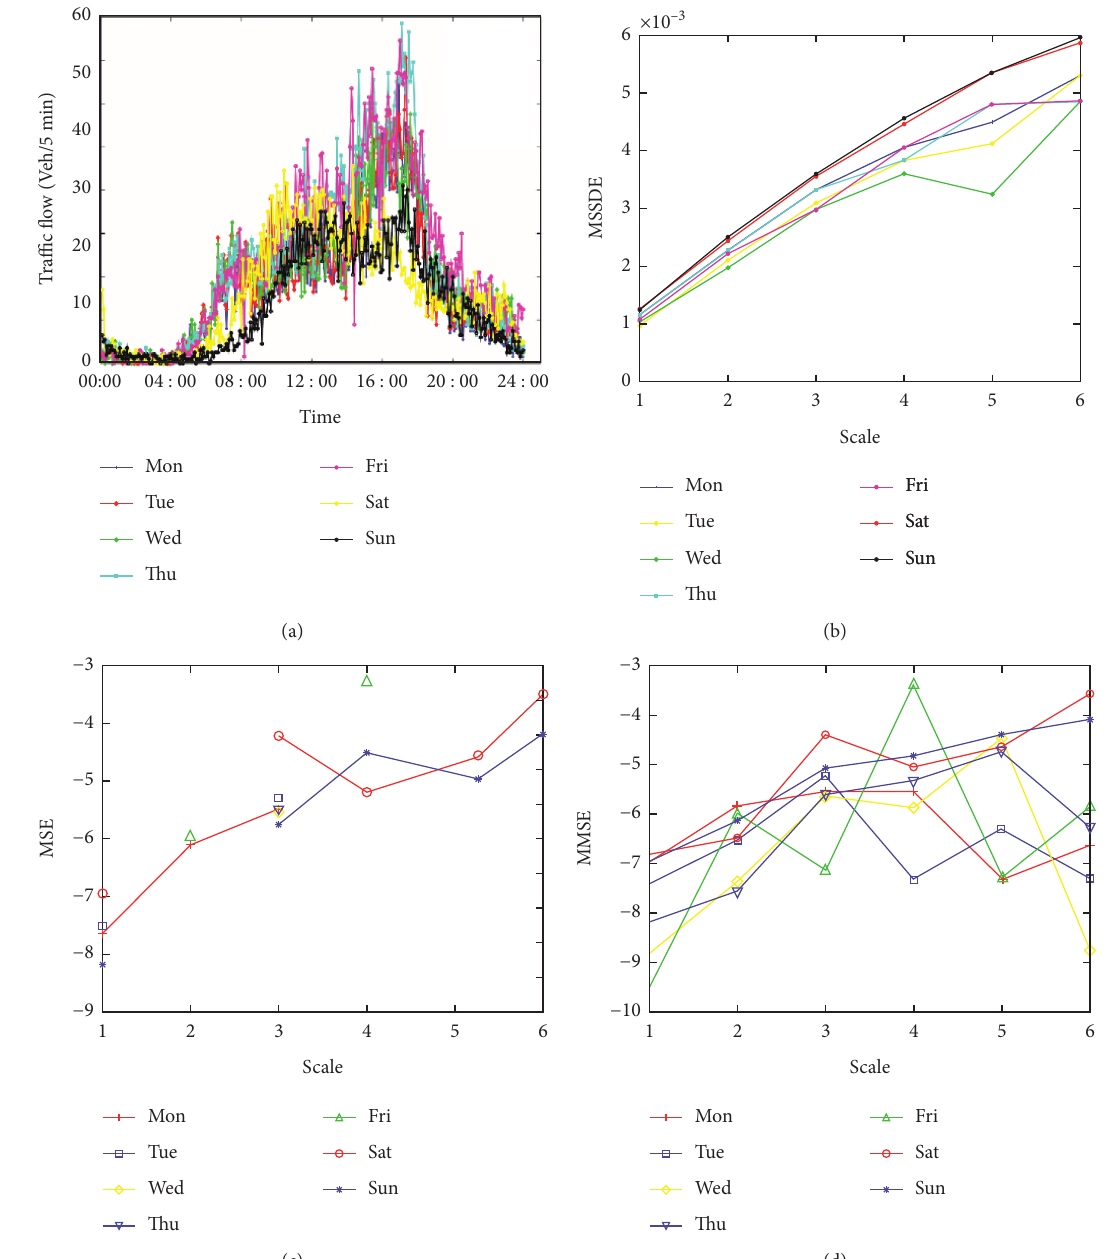
Figure 6: The result of traffic data collected by detector 5561. (a) The traffic data of week model from Monday to Sunday. (b) The analysis result of the traffic data using the proposed method. (c) The analysis result of the traffic data using the traditional MSE. (d) The analysis result of the traffic data using the